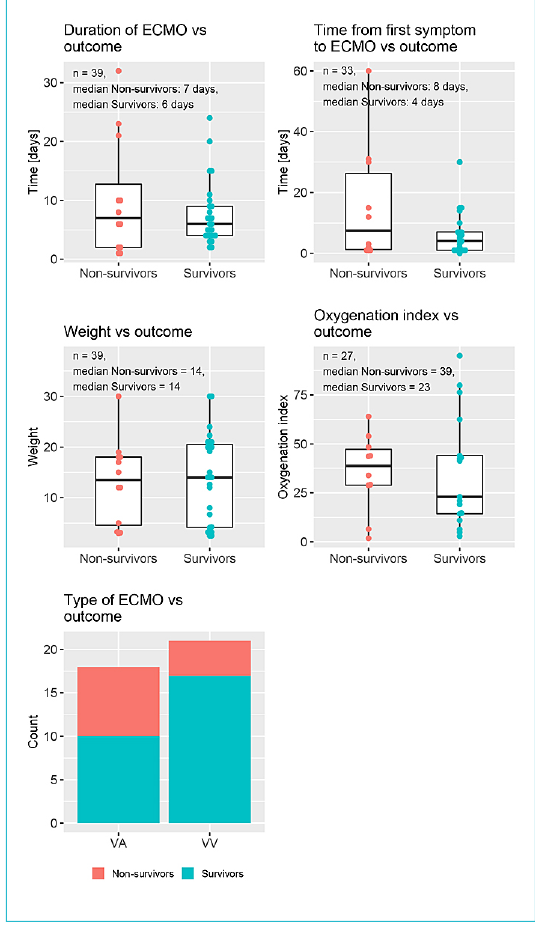
Figure 1: Distribution of the time-independent predictors stratified by outcome.